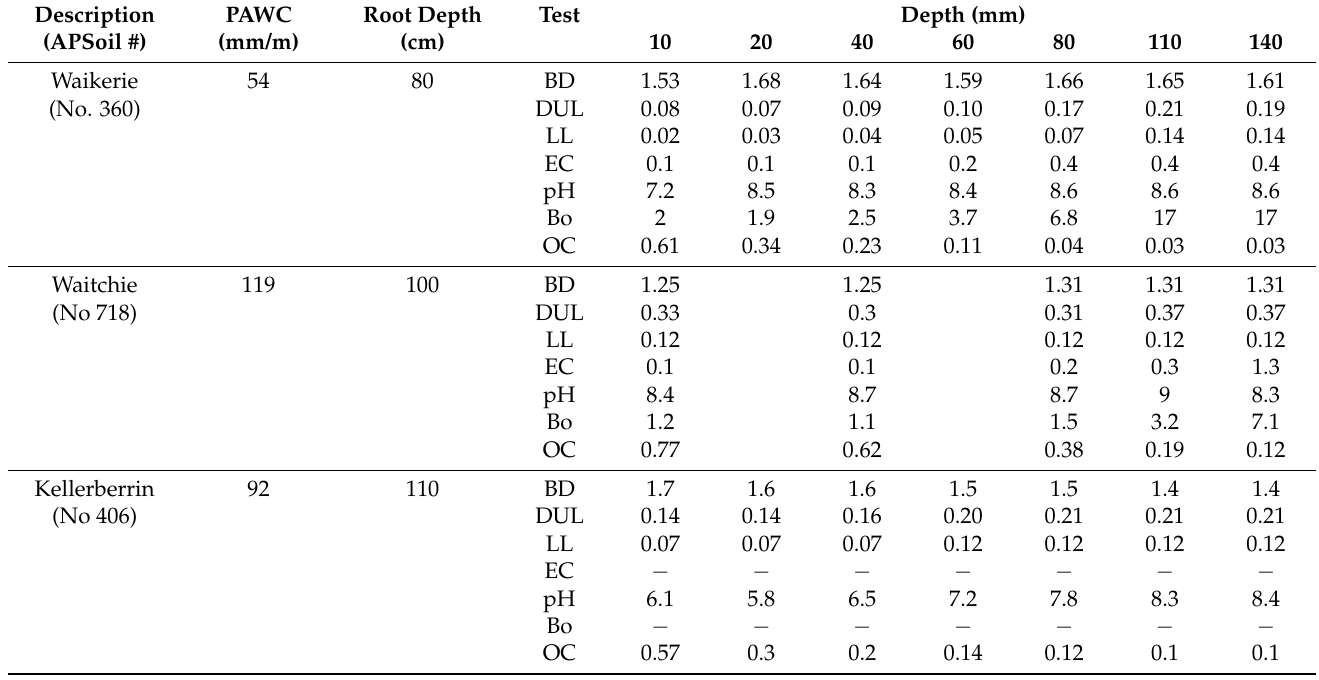
Table A2. Soil physical and chemical properties used in the simulations (PAWC is for the depth exploited by roots). Bo, OC and pH were used to estimate the rooting depth. PAWC: Plant available water content; BD: bulk density (g/cm 3 ), DUL is drained upper limit (volumetric %); LL is lower limit (volumetric %); EC is electric conductivity (1:5 saturated paste; dS/m); pH (1:5 water); Bo